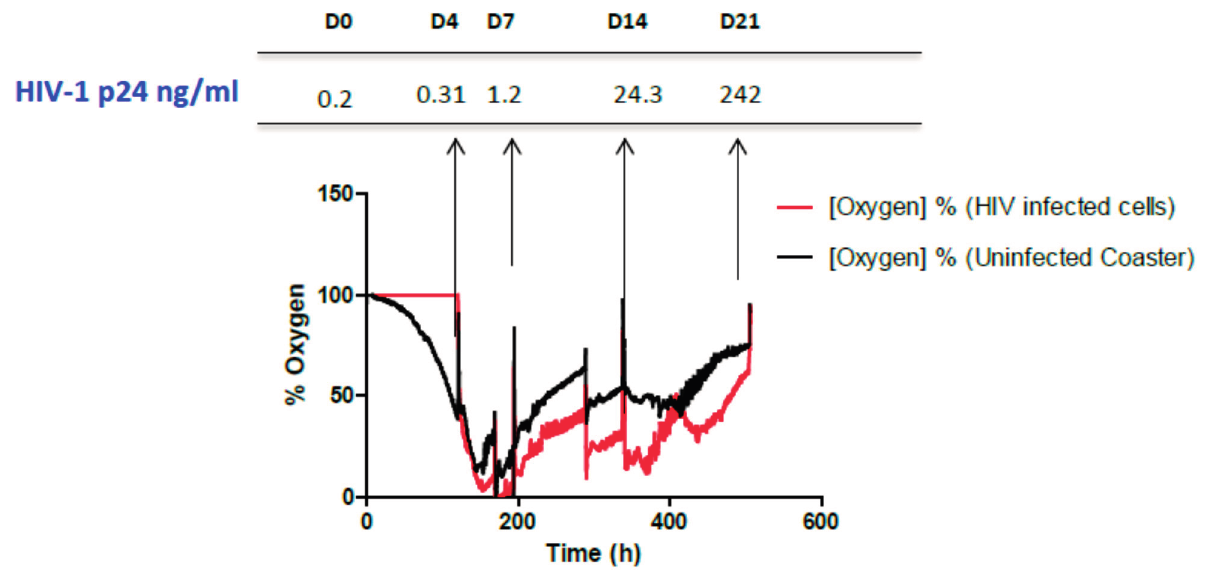
Figure 1. HIV culture monitoring through oxygen sensor and correlation with HIV-1 viral load (p24 ng/mL) quantification. Each spike in the figure indicates a BSL-3 visit was made to replenish cells and collect an aliquot of culture supernatant for HIV titer